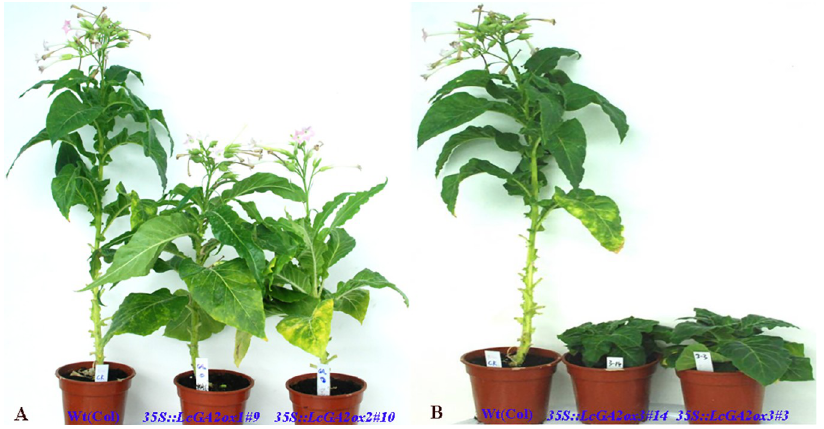
Fig 8. The phenotypes of transgenic tobacco lines ectopically expressing LcGA2ox1 , LcGA2ox2 and LcGA2ox3 .